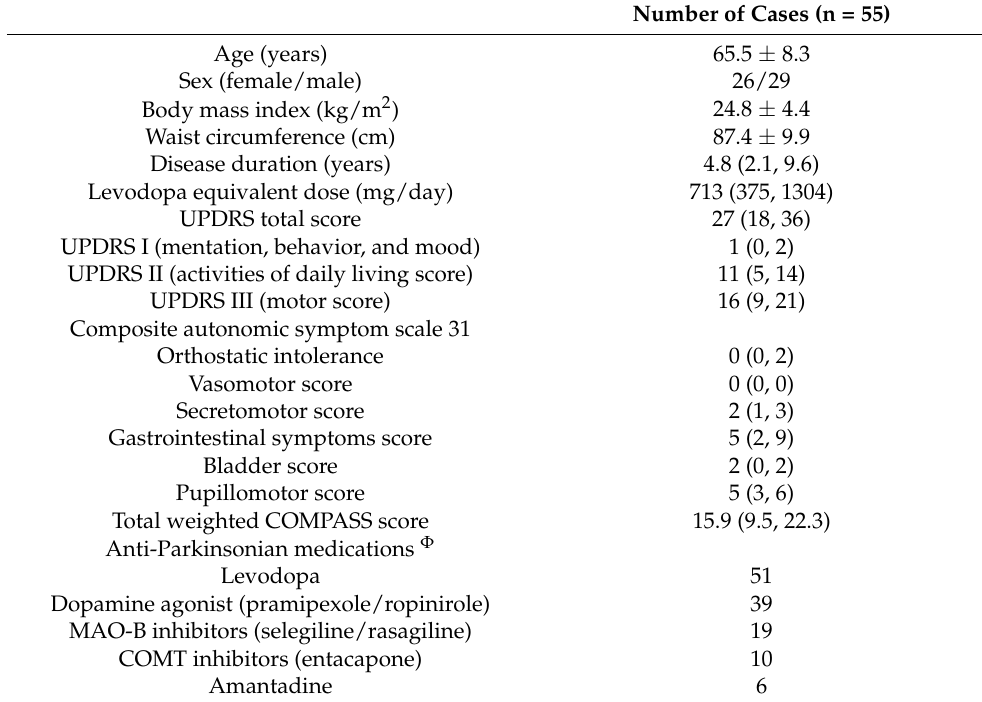
Table 2. Baseline characteristics of Parkinson’s